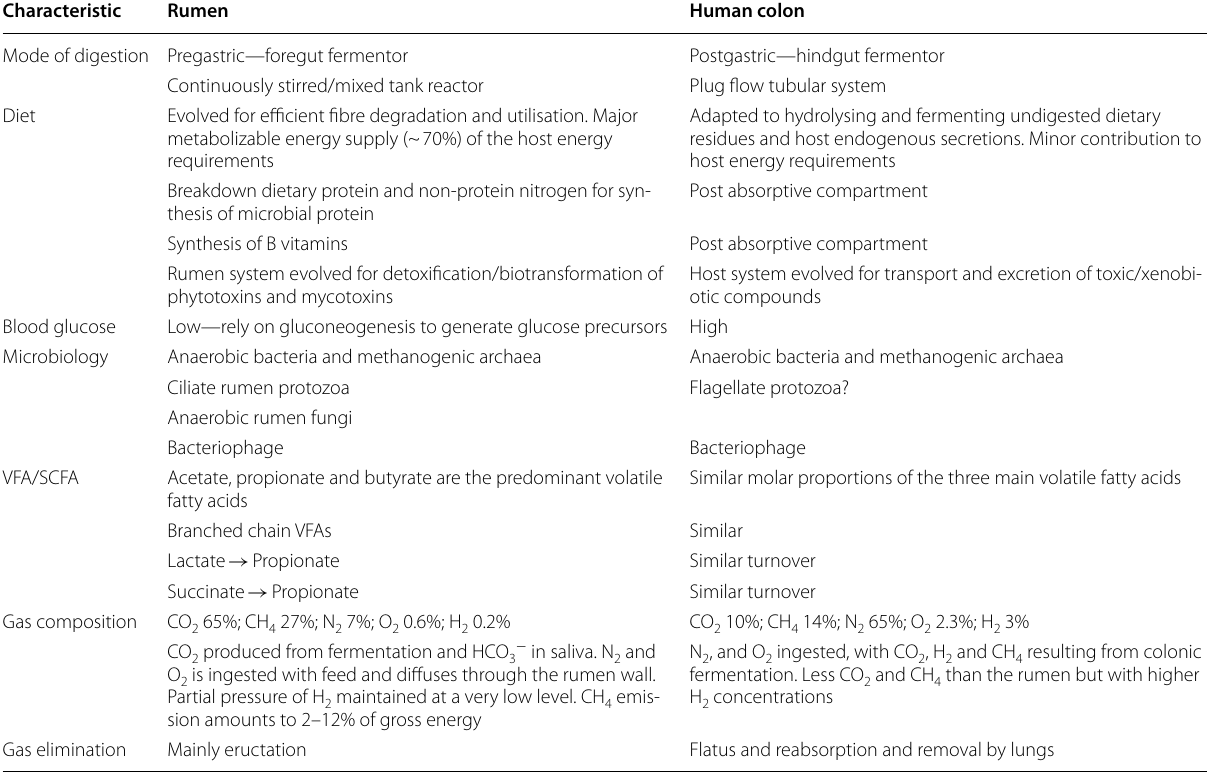
Table 1 Comparison of the rumen with the human colon—characteristics and properties of fermentative digestion in these gut compartments that specialize in fermentative digestion